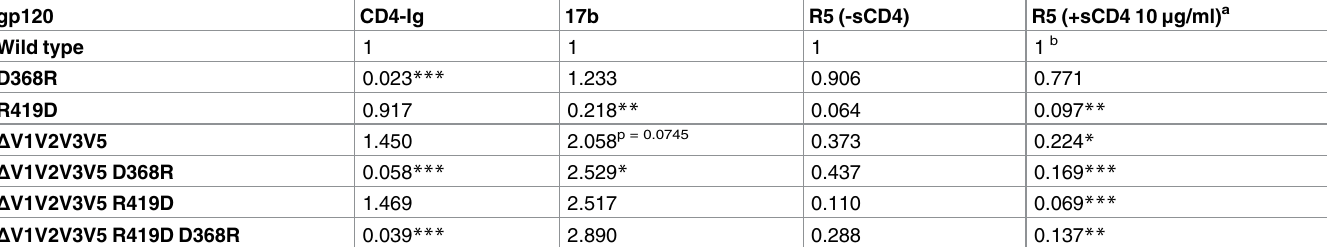
Table 2. Characterization of ligand binding to selectedHIV-1 YU2 gp120 proteins by